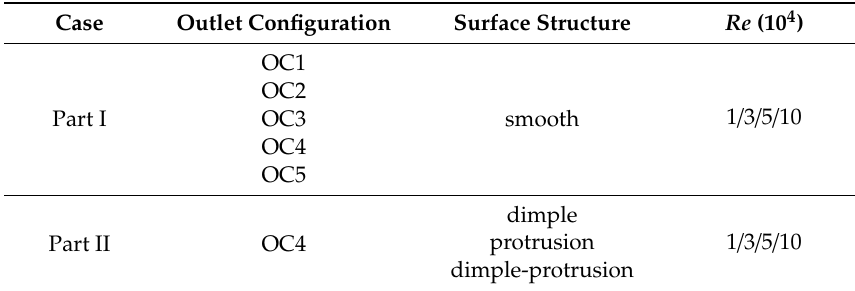
Table 1. Case settings of this